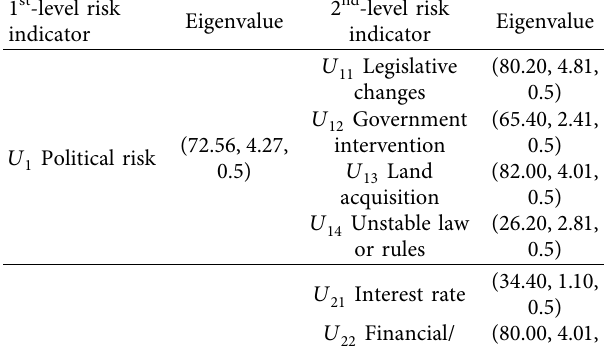
Figure 5: Cloud map of political risk.